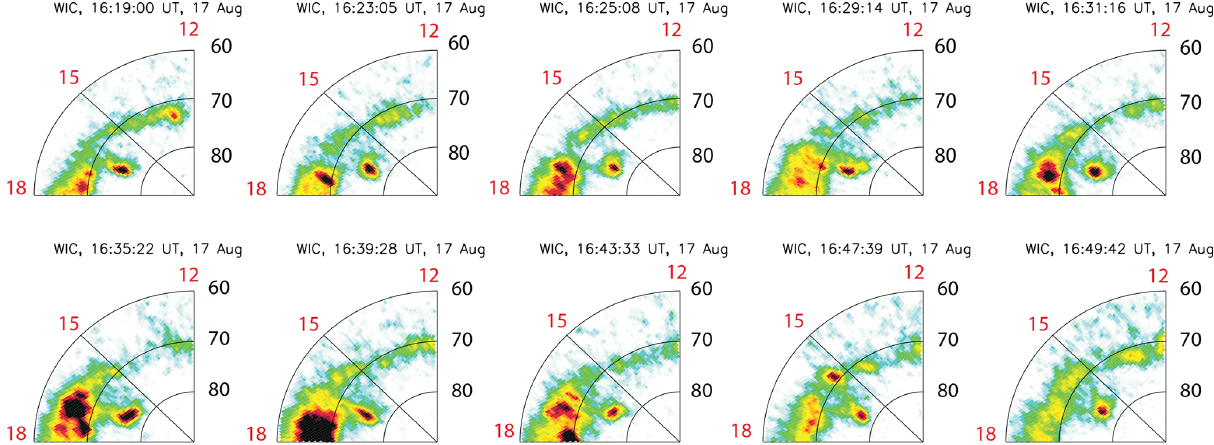
Figure 13. IMAGE WIC images. The auroral spot > 75 ◦ magnetic latitude, clearly detached from the auroral oval and indicative of lobe reconnection, is seen from 16:19 to 16:49UT, 17 August